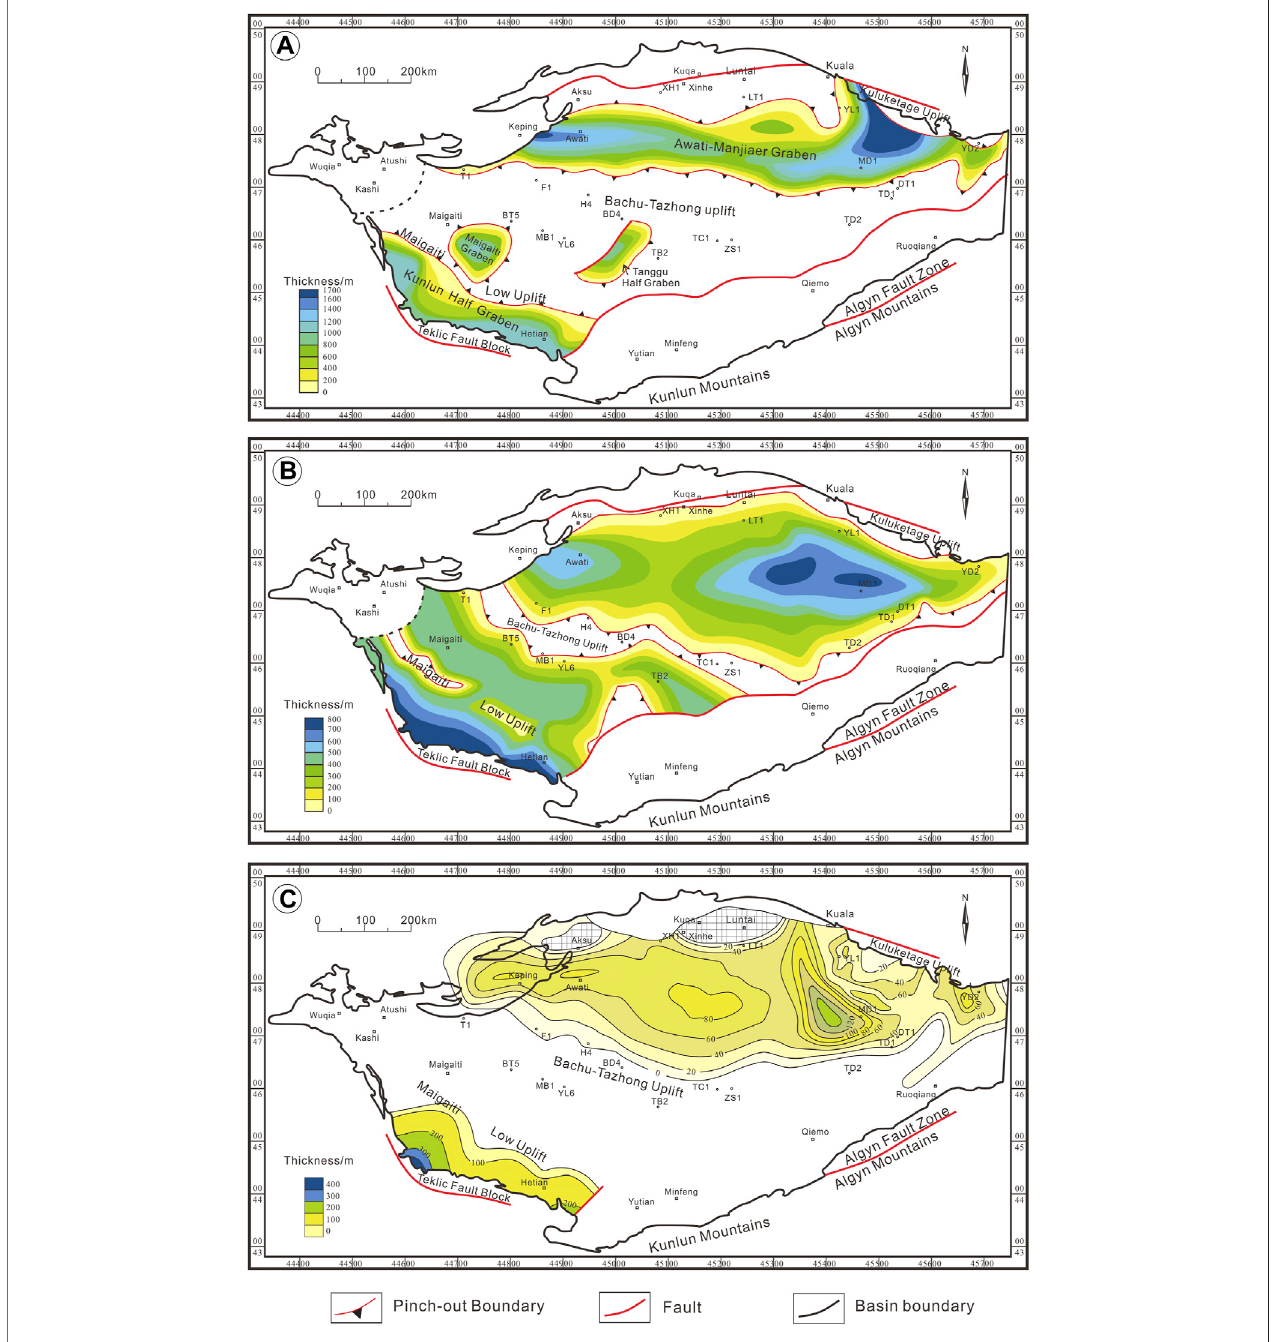
FIGURE 9 | Isopachs of the strata in the Tarim Basin. (A) Thickness variations within the Nanhua interval; (B) Thickness variations within the Sinian interval; (C) Thickness variations within the Yuertusi Formation of the Lower Cambrian.